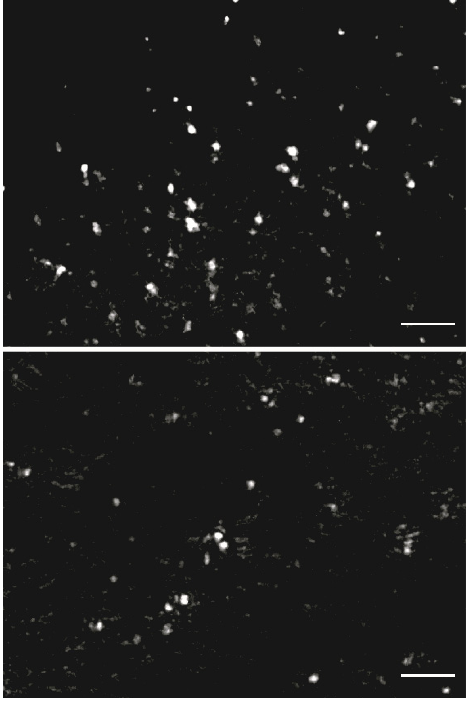
Figure 2. Total internal reflection fluorescence microscopy (TIRFM). Upper panel, TIRFM phase of tau aggregates. Lower panel, TIRFM tau aggregates images treated with compound 2 : bars 20 µm. Images were analyzed through FIJI.